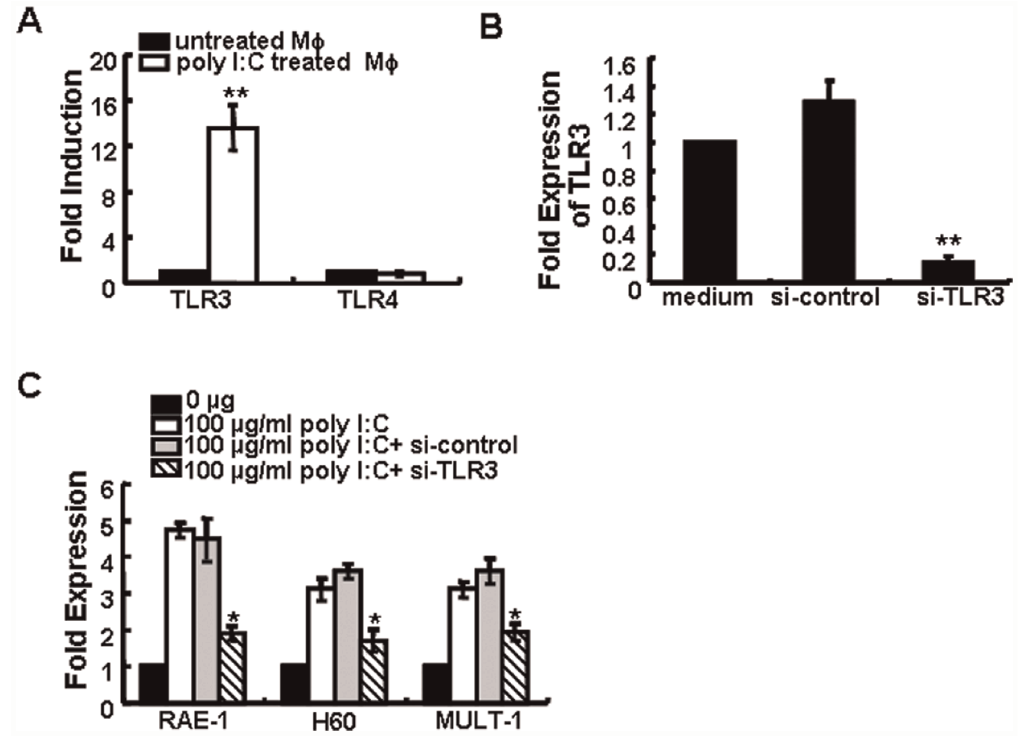
Figure 4. TLR3 is necessary for poly I:C-mediated up-regulation of NKG2D ligands by macrophages. Expression of TLR3 and TLR4 by RAW264.7 cells stimulated with 100 m g/ml poly I:C for 24 h was analyzed by RT-PCR (A). TLR3 mRNA levels of RAW264.7 cells were measured following incubation in media only or following treatment with si-TLR3 or siRNA control (si-control) for 24 h (B). The data are expressed as the folds 6 SD from at least three separate experiments. *p , 0.05, **p , 0.01 compared with the untreated group. RAW264.7 cells first transfected with si-TLR3 or si-control were stimulated with 0 or 100 m g/ml poly I:C for 24 h and the transcripts of the NKG2D ligands RAE-1, H60, and MULT-1 were detected by RT-PCR (C). The data are expressed as the mean induction folds 6 SD over untreated cells from at least three separate experiments. *p , 0.05, compared with si-control group.